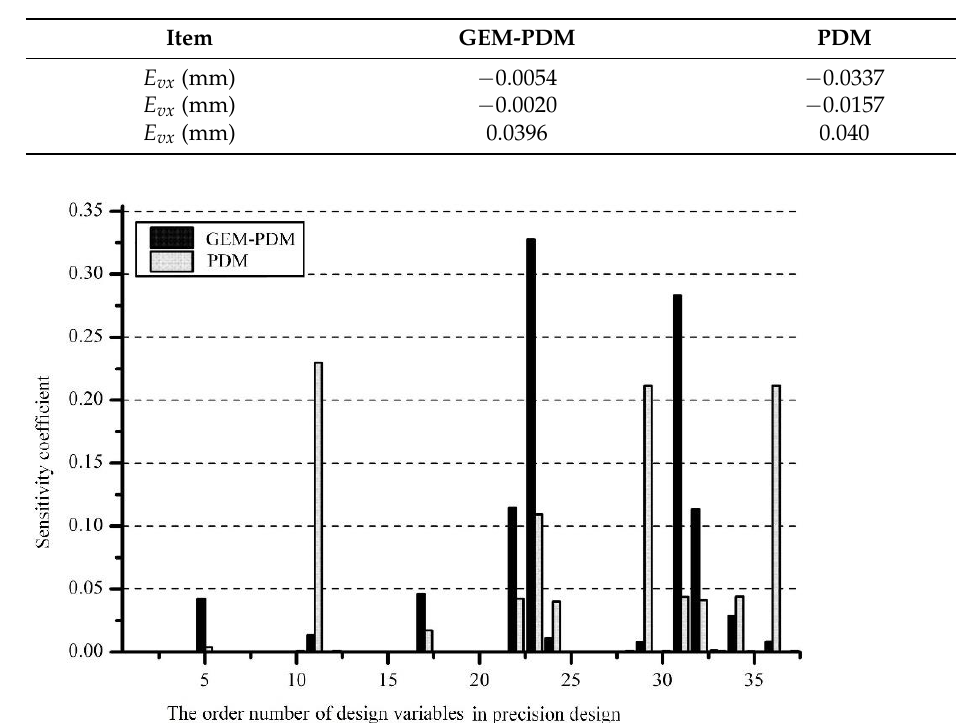
Figure 8. Comparison of error sensitivity coefficient results for each precision allocation method.